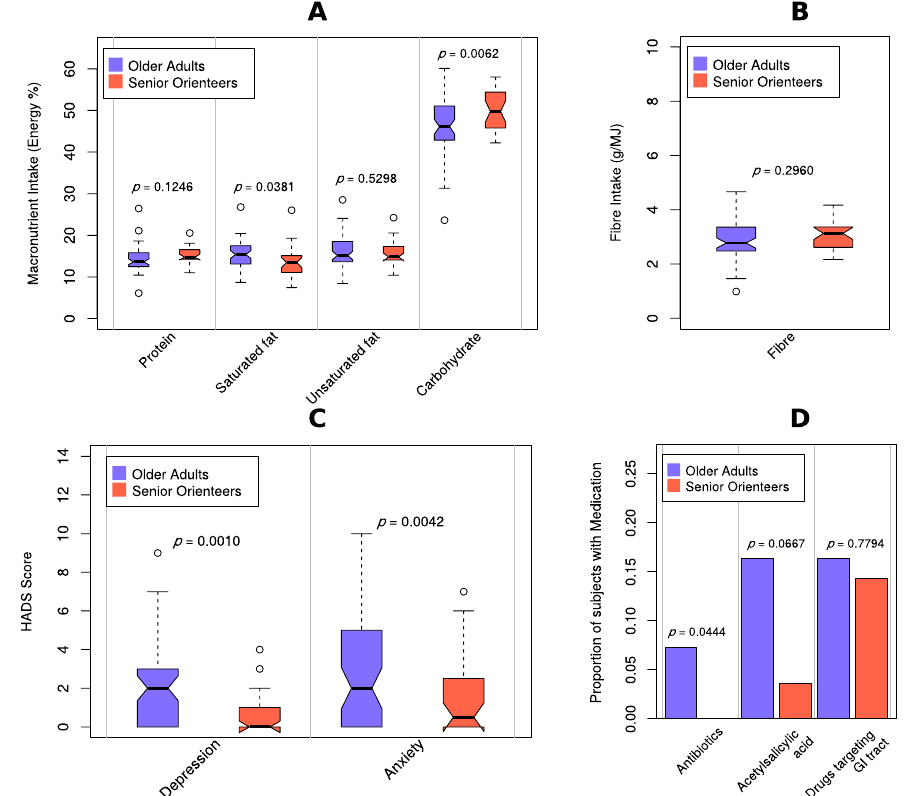
Figure 4. Comparison of covariates. Boxplots of covariates stratified for older adults and senior orienteers, including descriptive p-values from Welch’s t -test. ( A ) Macronutrients measured by energy percentage (E%). ( B ) Fibre measured by grams per megajoule (MJ). ( C ) Hospital Anxiety and Depression Scale (HADS) score. ( D ) Bar plot for medication covariates for older adults and senior orienteers, including descriptive p -values from chi-square test.